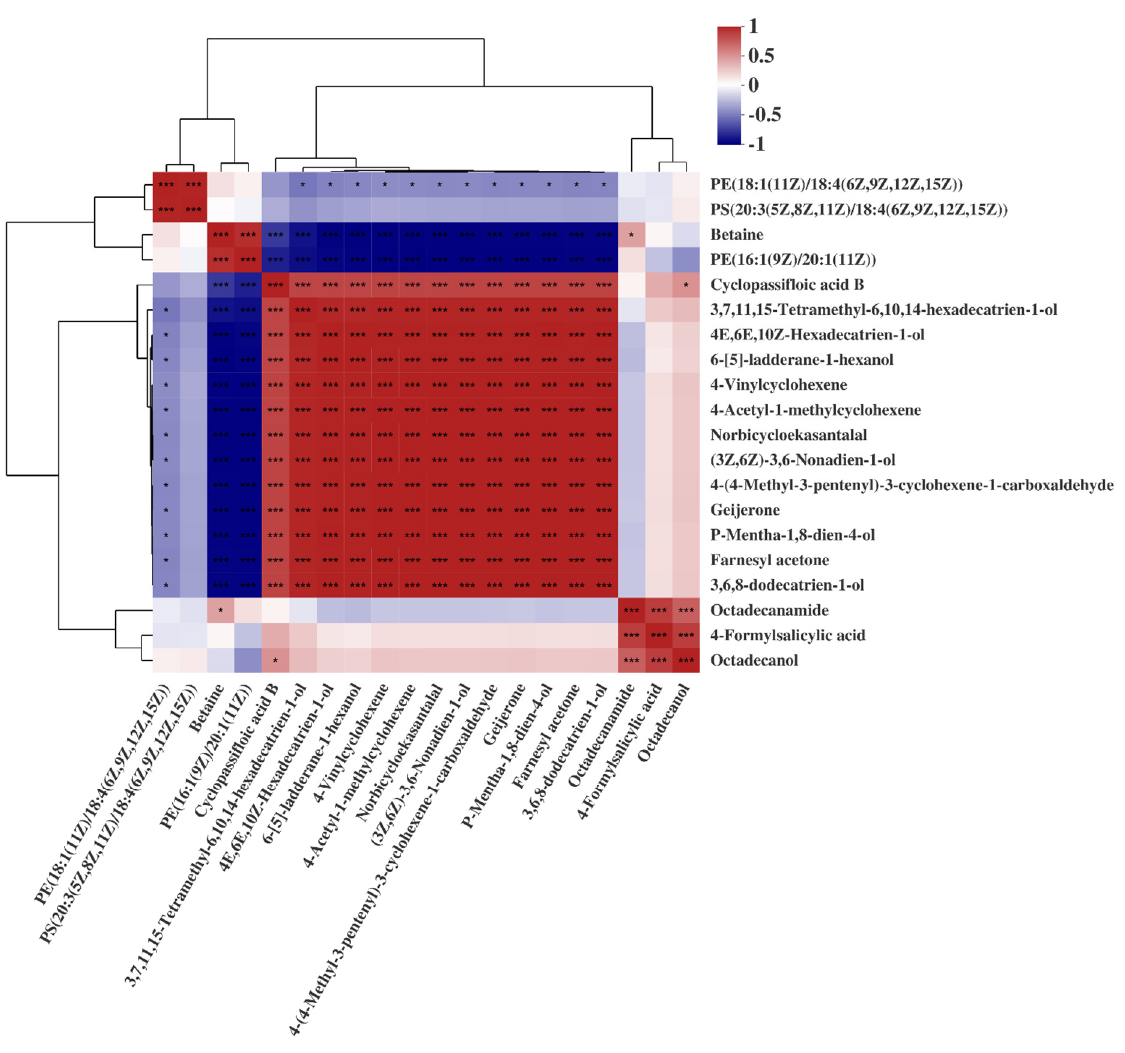
Figure 2. Pearson correlation analysis of treated and untreated P. palleroniana . Levels of significance are defined as * p < 0.05, and *** p <